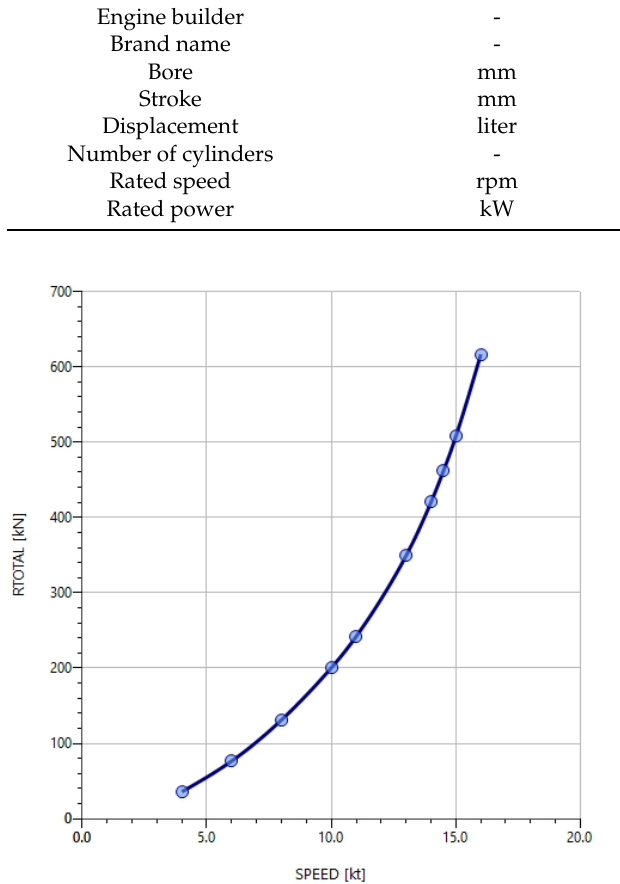
Figure 1. Total resistance of the bulk carrier at different ship speeds.